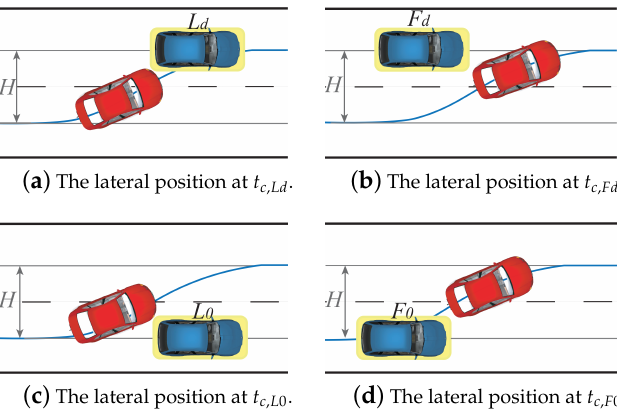
Figure 6. The critical lateral position for the left lane-change